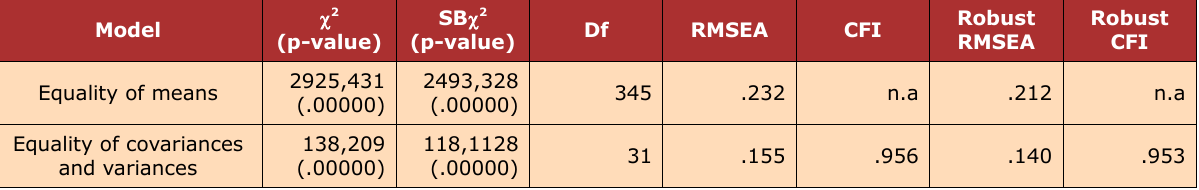
Table 2. Goodness of fit indexes for configural invariance (means and